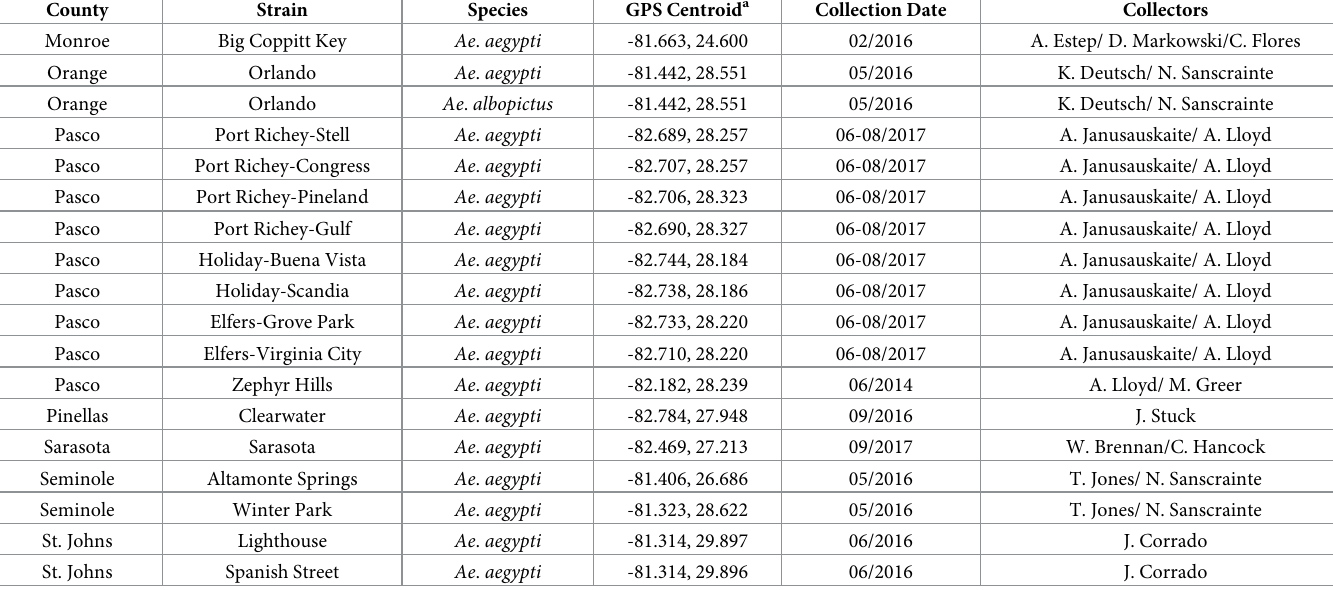
When the RR is between 5 and10, the mosquitoes are considered to have moderate resistance. A RR greater than 10 indicates that mosquitoes are highly resistant [31].